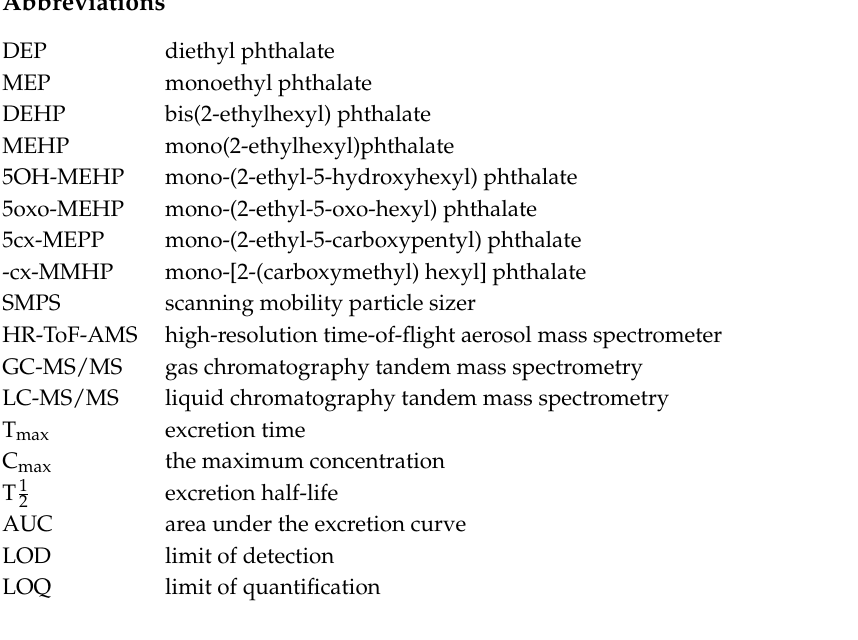
s1. Table S1: Excretion kinetics of D 4 -DEP metabolites, Table S2: Excretion kinetics of D 4 -DEHP metabolites, Table S3: Total excreted dose after inhalation exposure to D4-DEP and D4-DEHP, Table S4: Total excreted dose after combined inhalation and dermal and dermal exposure to D4-DEP, Table S5: Analytical details for quantification of phthalate esters using GC-MS/MS, Table S6: Analytical details for quantification of phthalate metabolites using